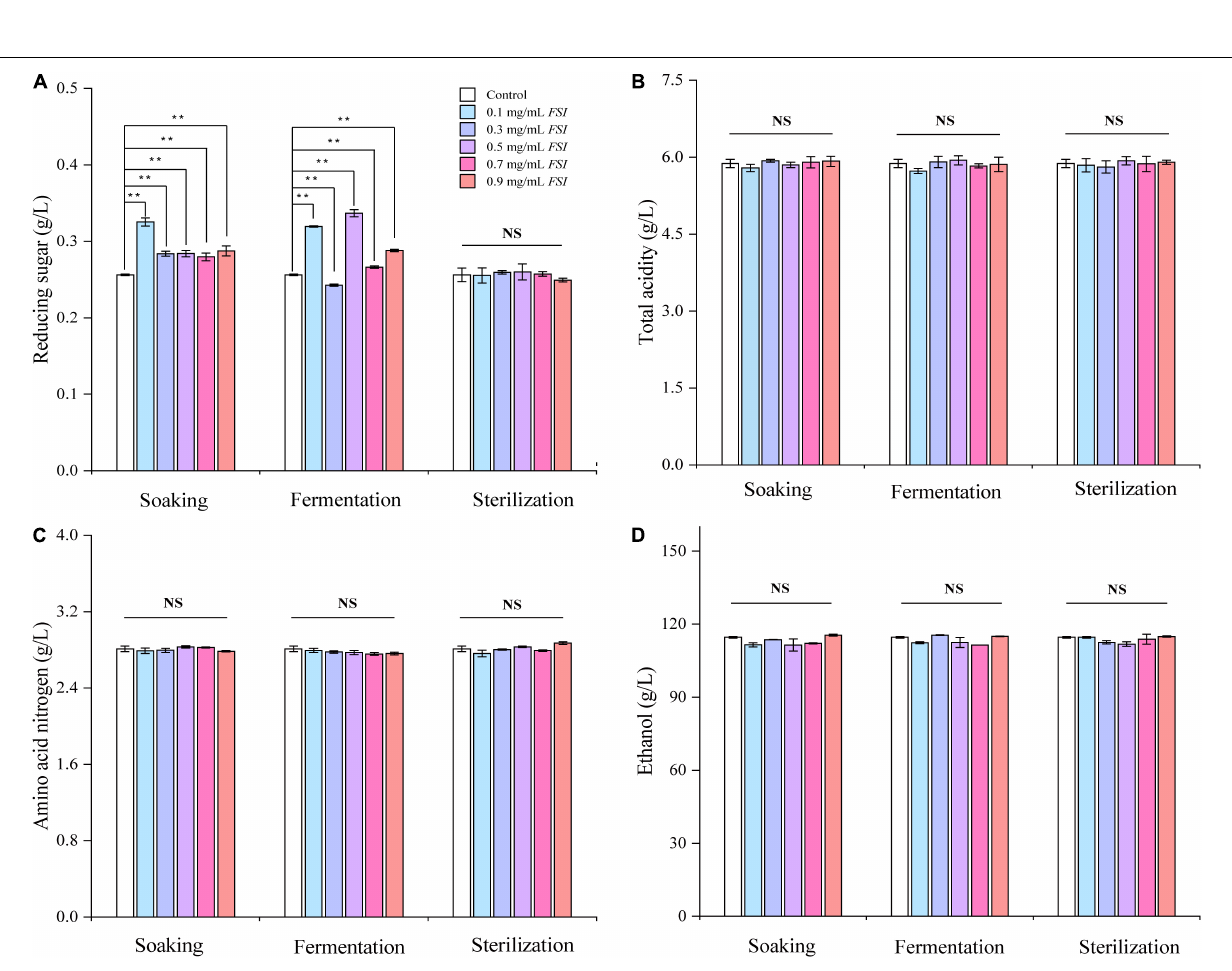
FIGURE 3 | The oenological properties of HQW treated with various concentrations of FSI during different brewing stages, comprising reducing sugar content (A) , total acidity (B) , amino acid nitrogen content (C) , and ethanol content (D) . **Indicates significant differences ( p < 0.01, Duncan’s tests) between different HQW. NS indicates no significant difference between the wine